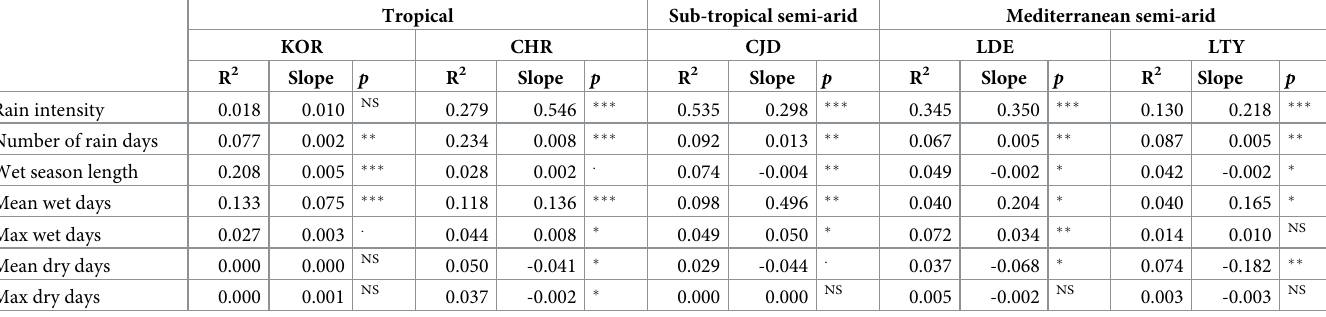
Table 4. Slope parameter estimates and variance in ring-width index (RWI) explained by annual rainfall